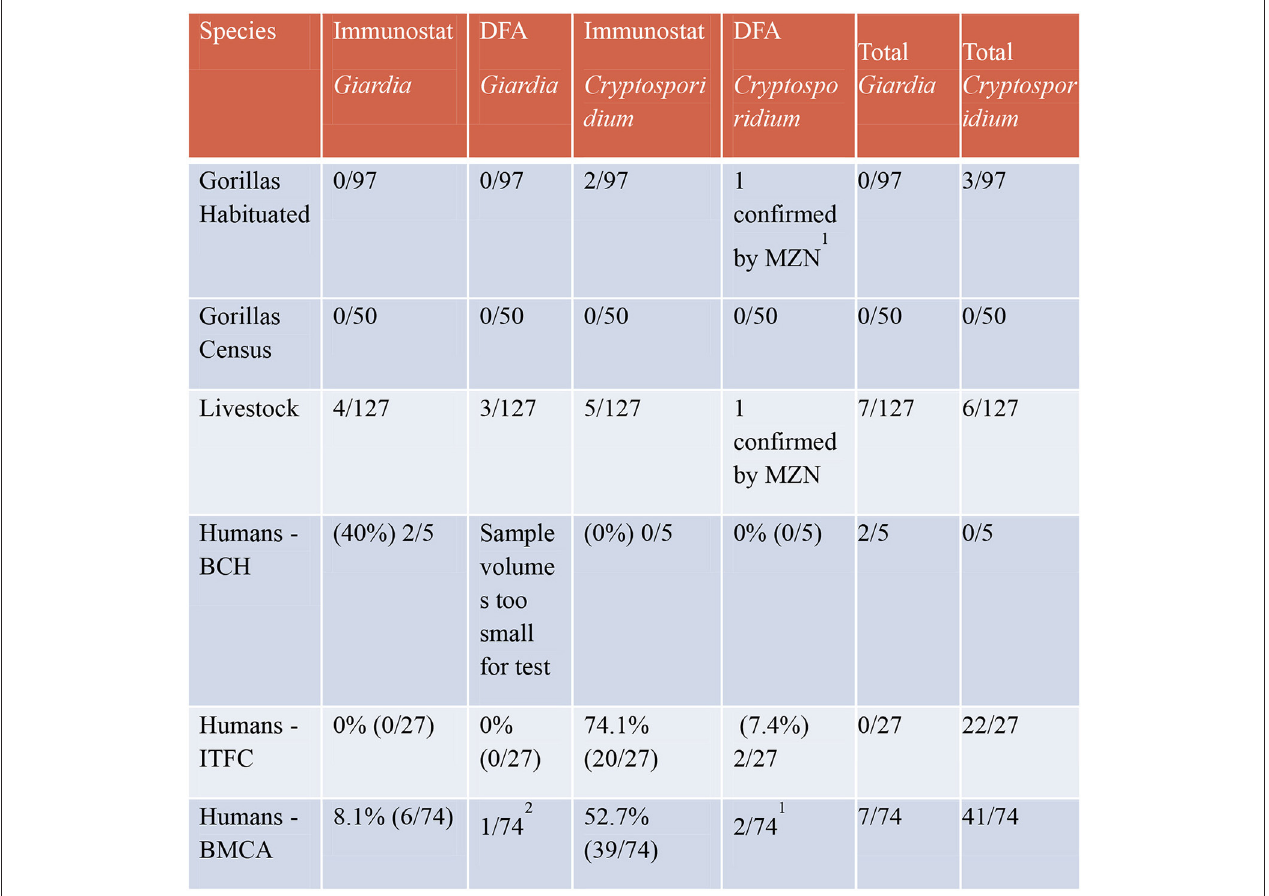
FIGURE 2 | Results of ImmunoSTAT and direct immunoflorescent antibody tests for Giardia and Cryptosporidium .